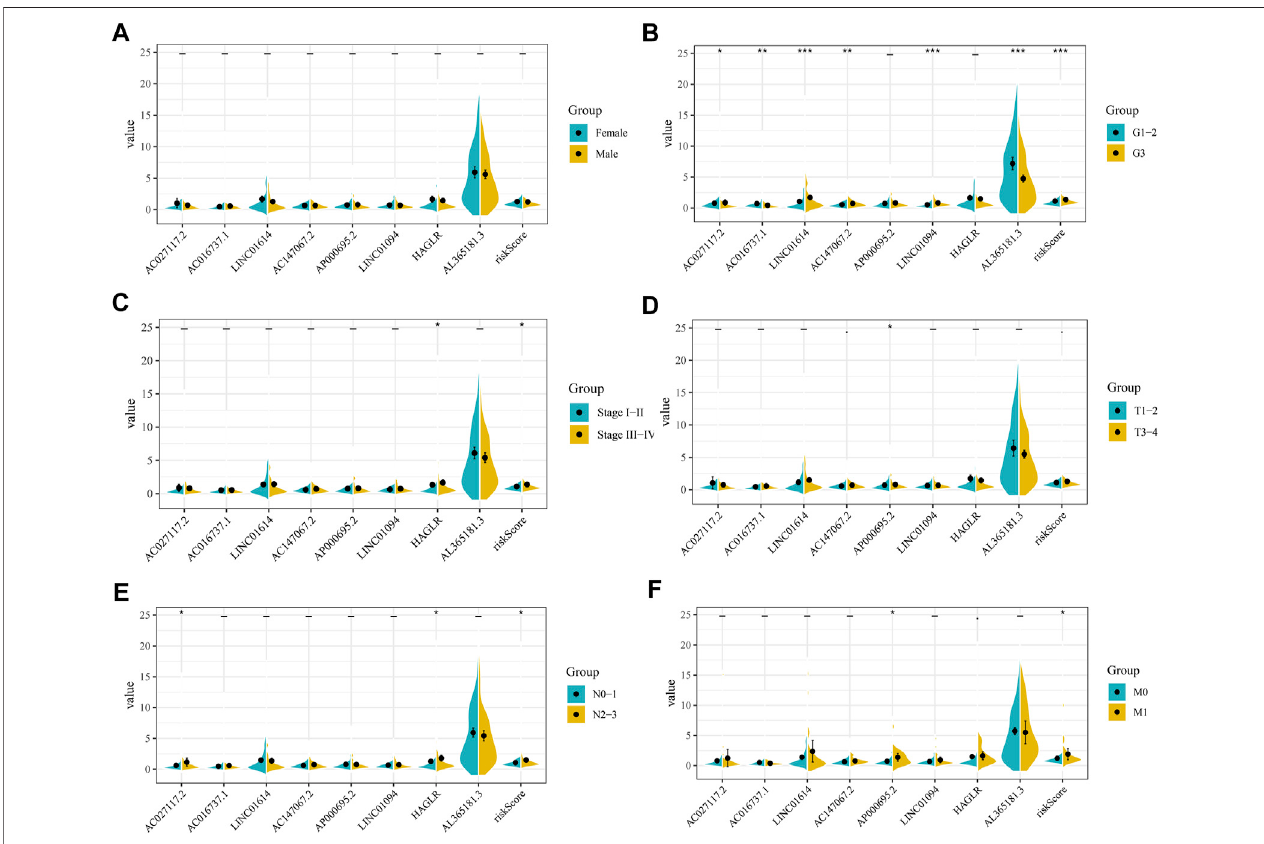
FIGURE4| ClinicalcorrelationofriskscoreandCMLs. (A) :LevelofriskscoreandmodelCMLsindifferentgenderpatients; (B) :LevelofriskscoreandmodelCMLs in different grade patients; (C) : Level of risk score and model CMLs in different stage patients; (D) : Level of risk score and model CMLs in different T stage patients; (E) : Level of risk score and model CMLs in different N stage patients; (F) : Level of risk score and model CMLs in different M stage patients.